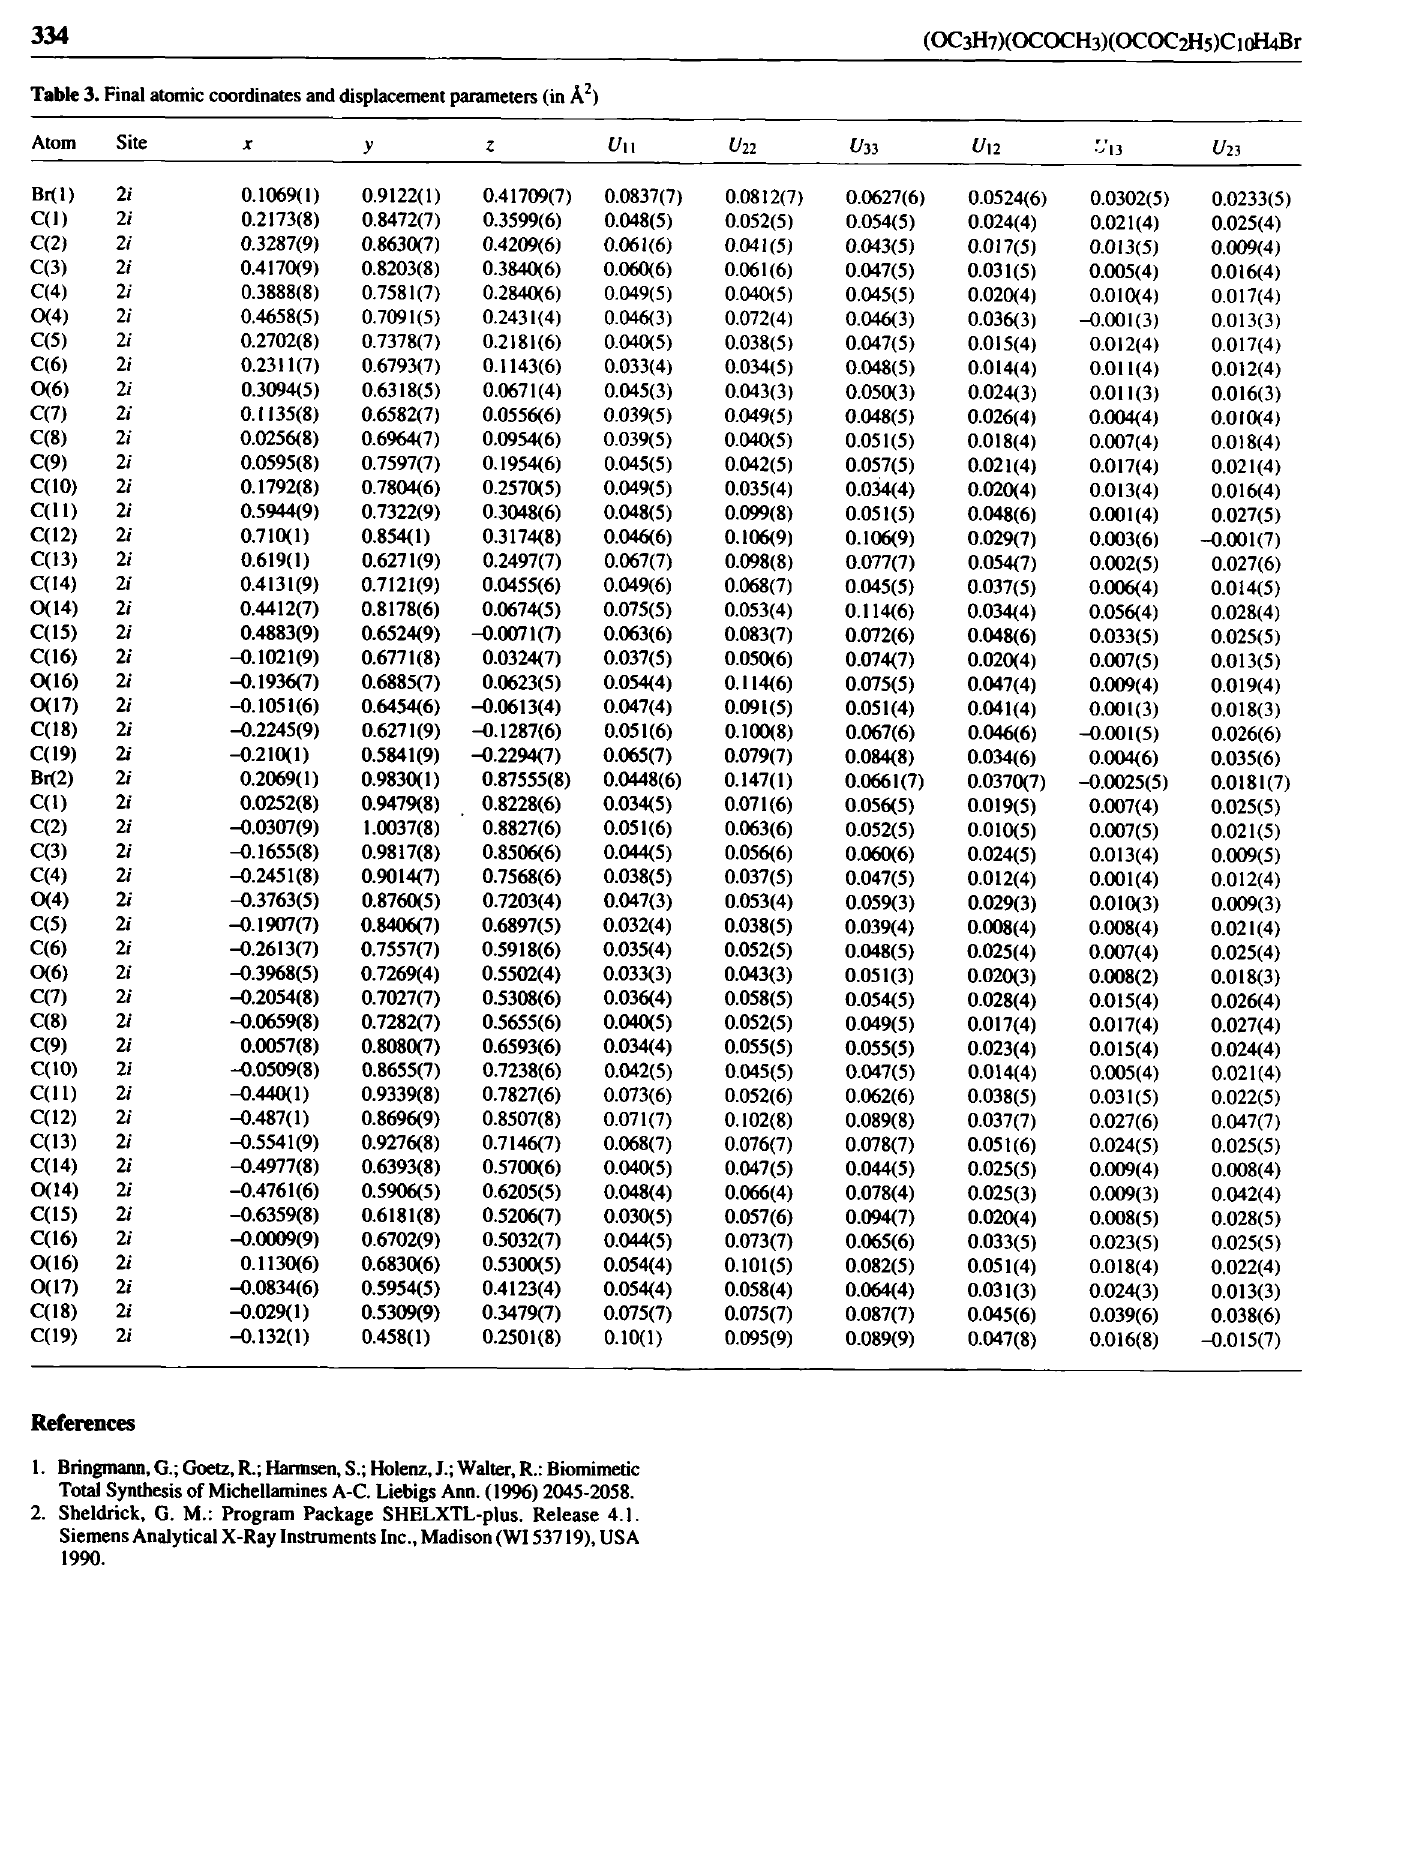
Table 3. Final atomic coordinates and displacement parameters (in